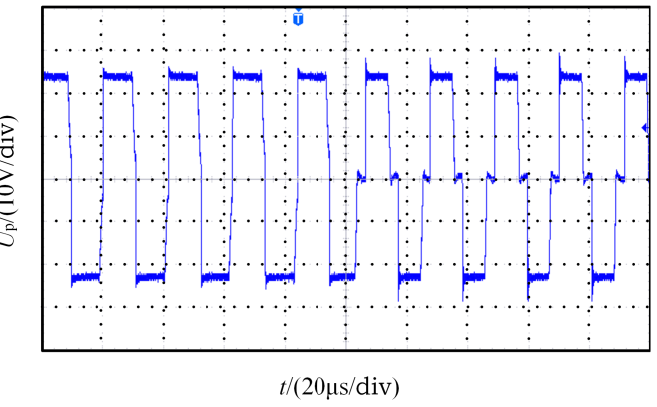
Figure 4. Inverter output voltage.